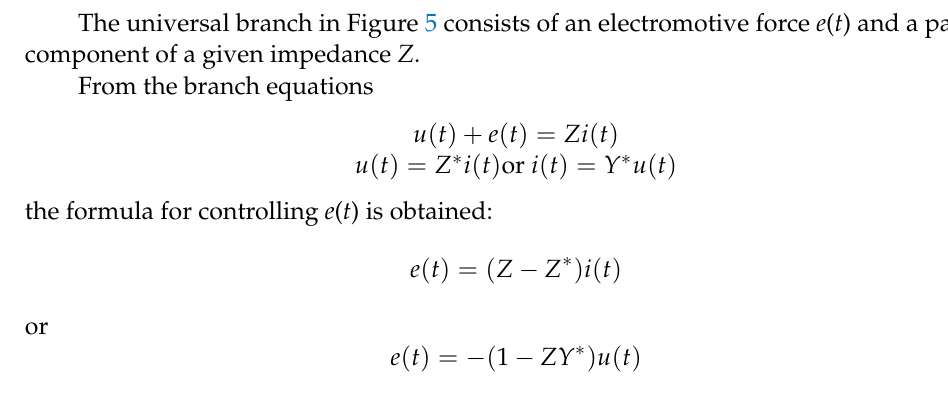
Figure 5. Diagram implementation of a two-terminal circuit of a given impedance Z * or admittance Y * by means of a current-controlled or voltage-controlled voltage source.